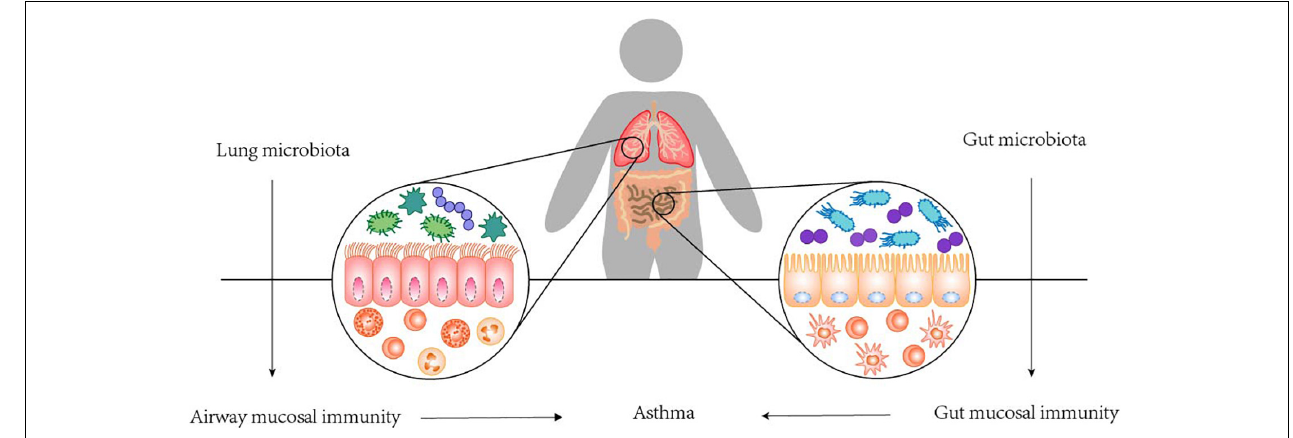
FIGURE 3 | The gut-lung